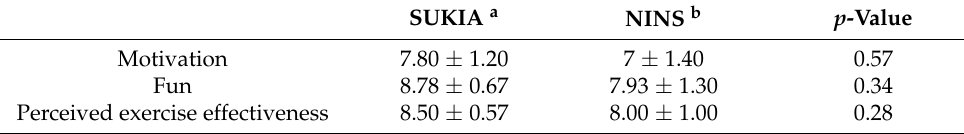
Table 6. Post-questionnaire for the motivation, fun, and perceived exercise